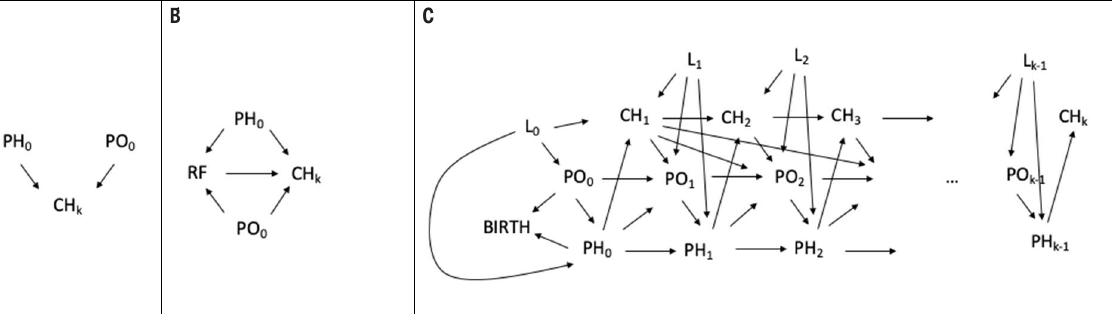
Figure 1. Conceptual framework for investigating causal relationships between work and health of parents also in relation to the children’s health. [PH i =parents' health at time i (i=0: baseline, ie, during pregnancy or at birth); PO at time i.] A. Occupation and health of parents at baseline (during pregnancy or at birth) as possible determinants of child’s health. B. Causal relationship between a risk factor and child’s health, controlling for occupation and health of parents at baseline. C. Possible more complex causal relationship between occupation and health of parents, and health of the child at different time points, including